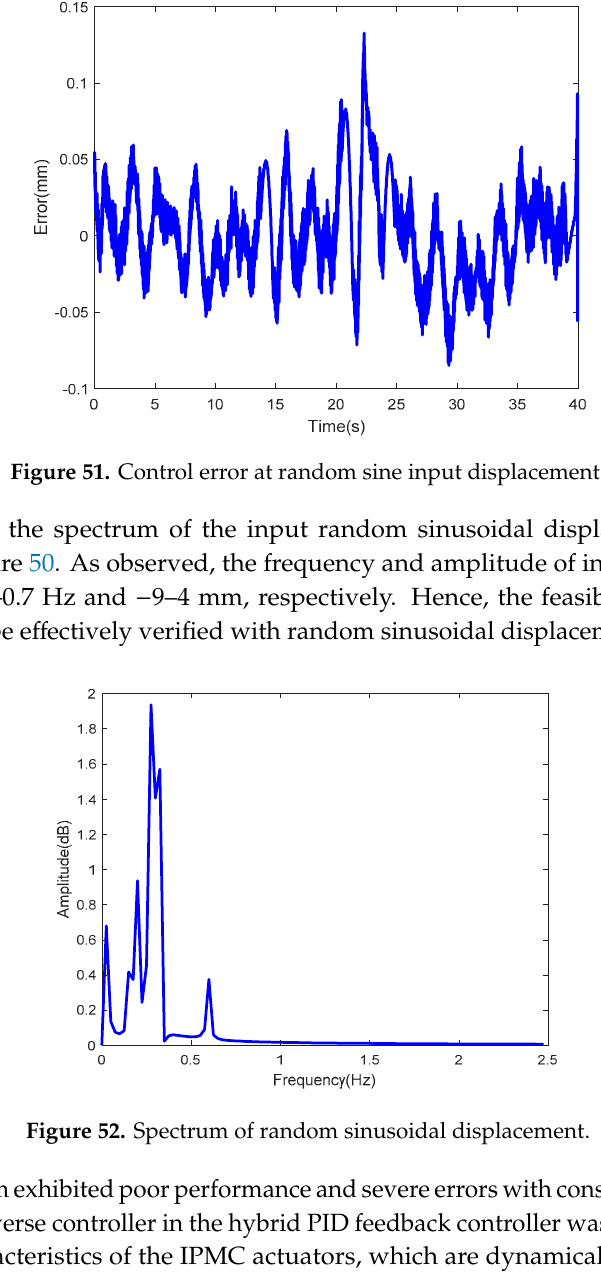
Figure 49. Control results at random sine input displacement.